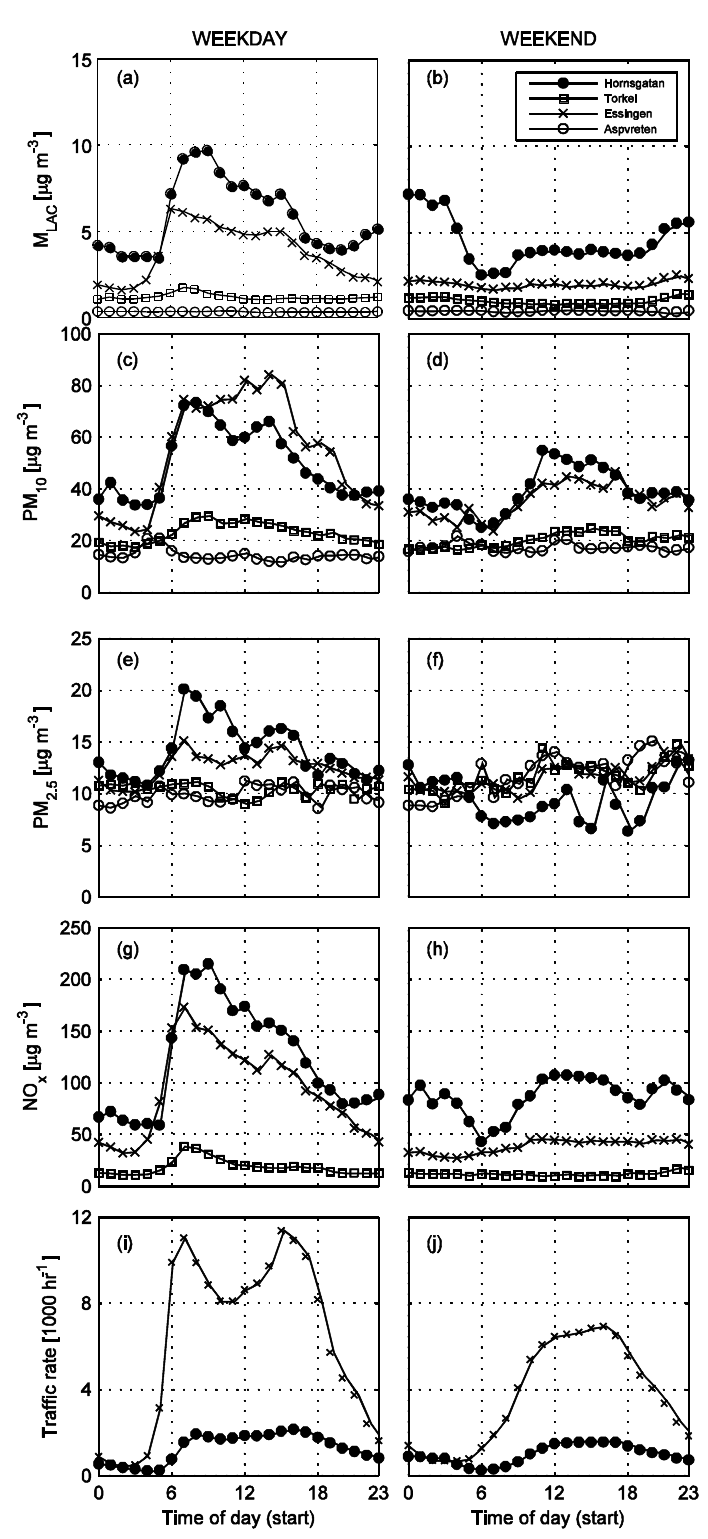
Fig. 6. Average diurnal variation of M LAC , PM 10 , PM 2 . 5 , NO x , and traffic rate on weekdays and weekends for the four stations in the Fig. 6